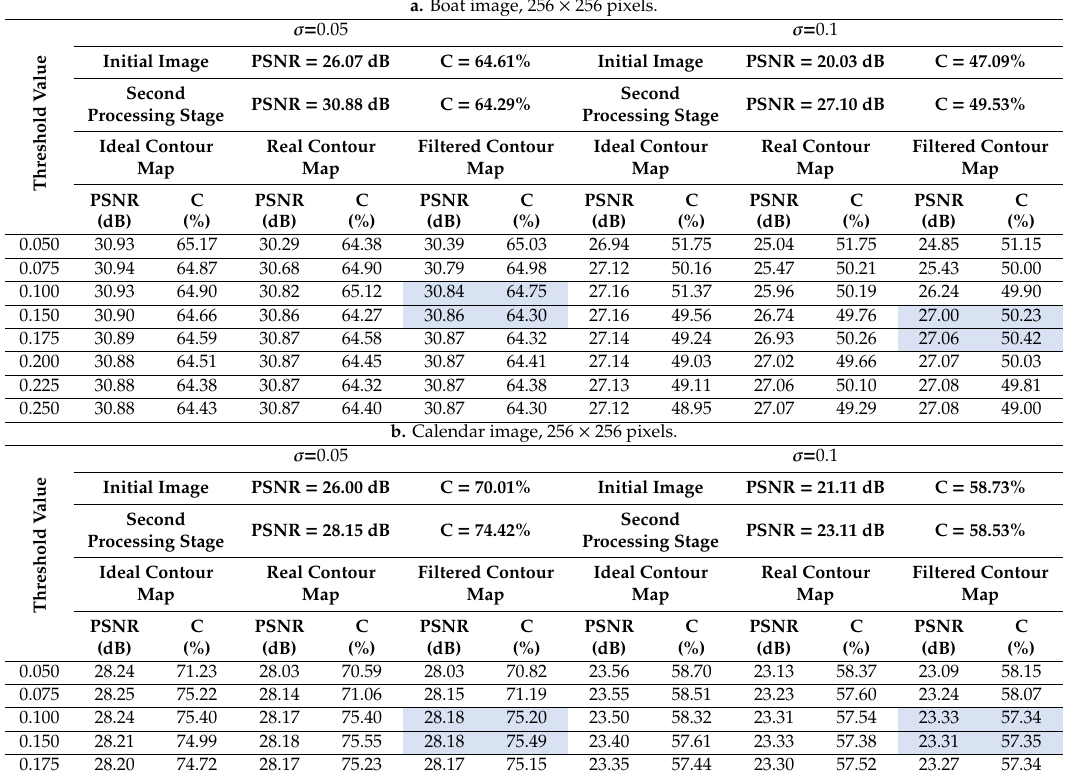
Table A1. Dependence on the threshold value used to obtain the contour map from the hierarchical correlation map, in the case of the proposed method. Results obtained by using the ideal, real and filtered hierarchical correlation map are presented. a. Boat image, 256 × 256